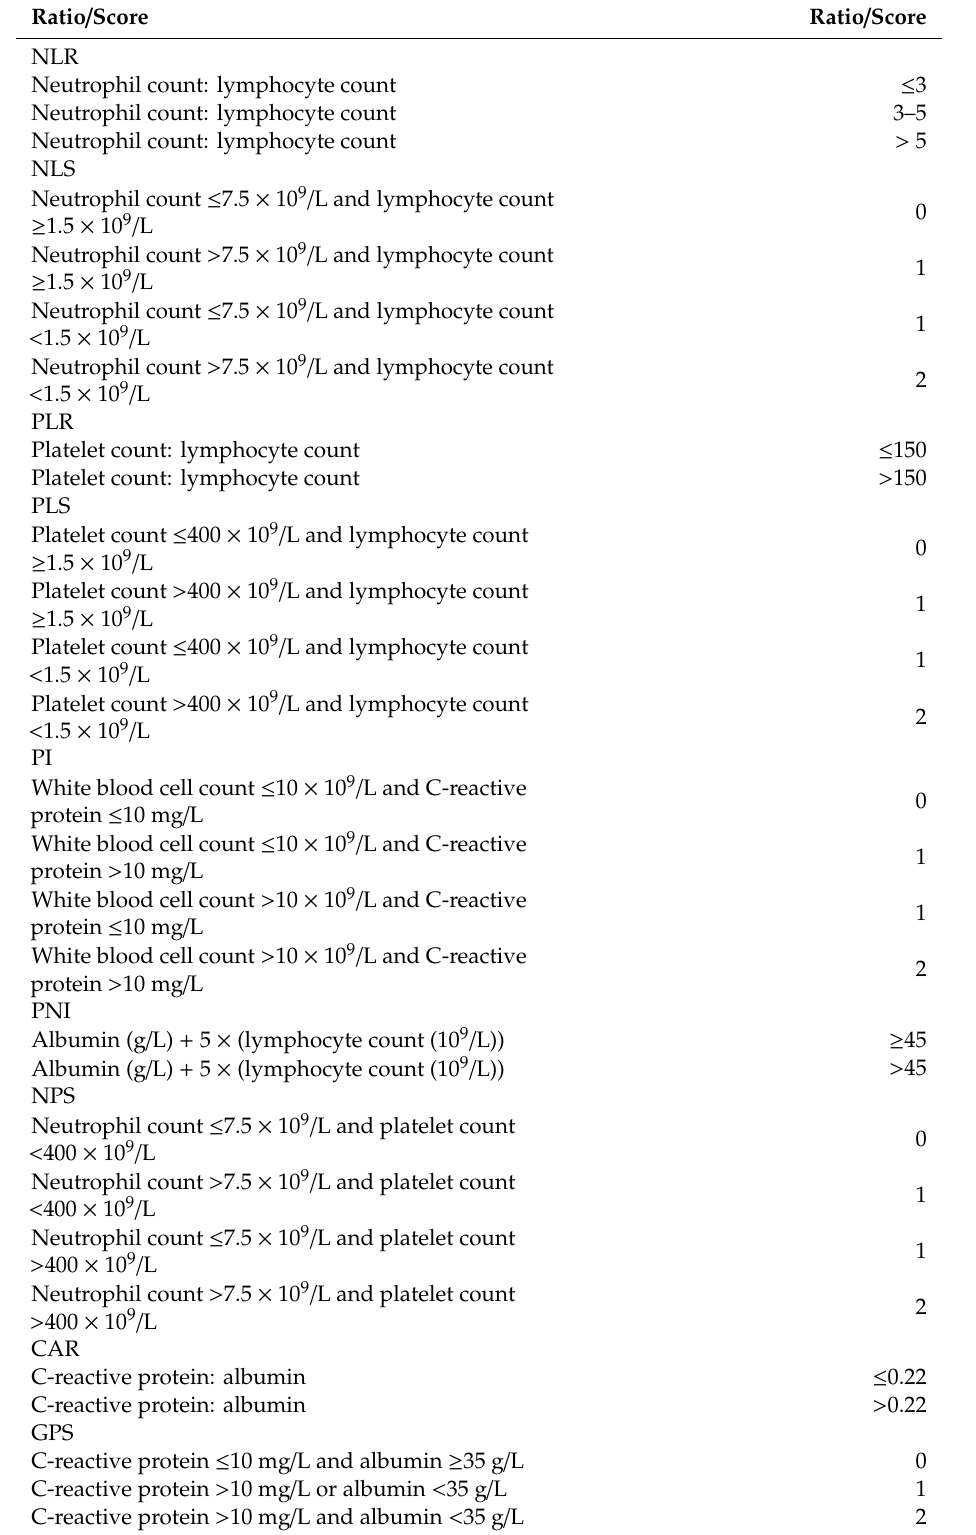
Table 9. Systemic inflammation-based prognostic ratios and